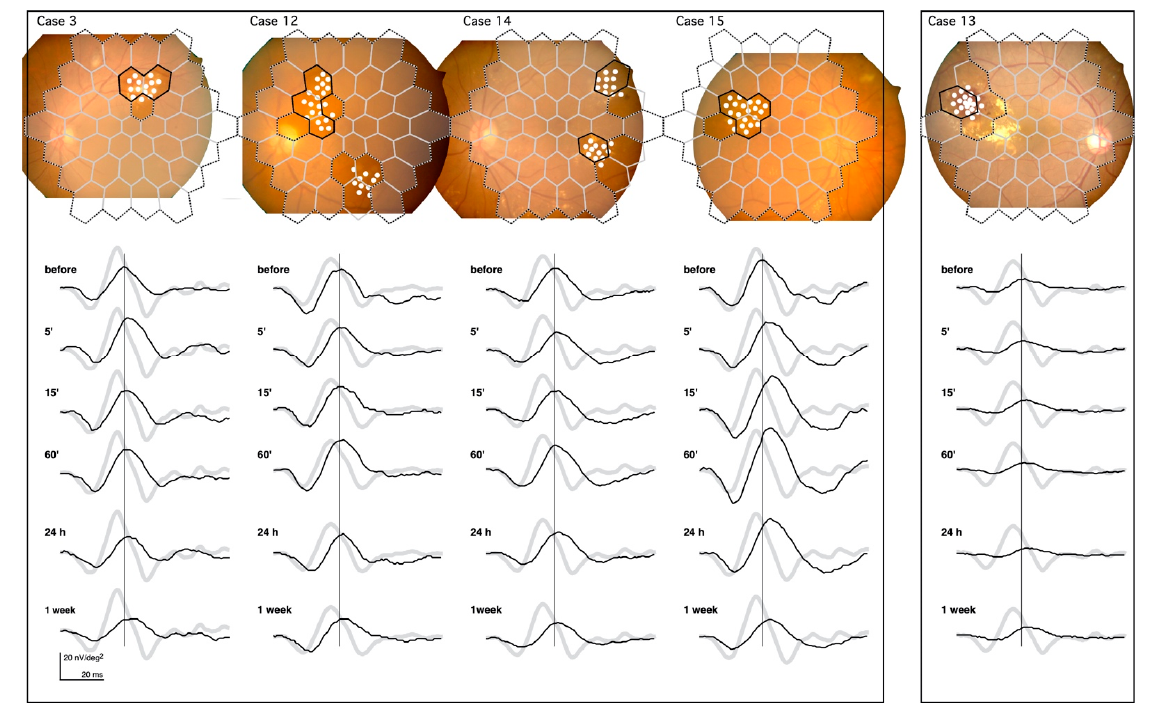
Figure 3. mfERGs recorded from the irradiated area of five cases. The solid borders superimposed on the fundus images represent the location of the mfERGs from the irradiated areas. Dashed borders represent the non-irradiated areas. The mfERGs were unchanged throughout the recordings (not shown). The boundary regions without solid borders were excluded from the analyses. The pale mfERGs represent the mean normative mfERGs obtained from 8 healthy volunteers. Note that the PC was performed at different retinal sites in each case, and the normative mfERGs were obtained from the corresponding retinal sites.